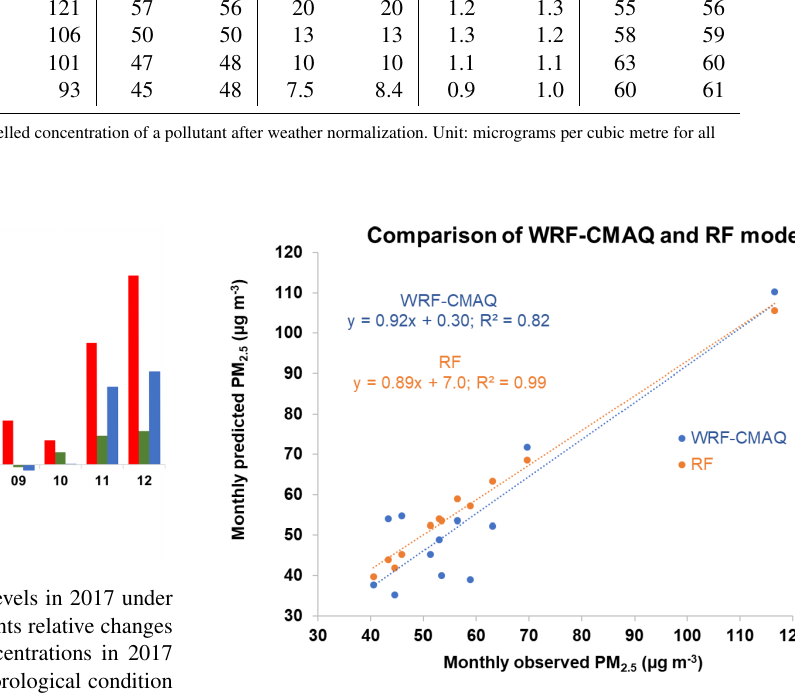
Table 1. A comparison of the annual average concentrations of air pollutants before and after weather normalization. Pollutants PM 2 . 5 PM 10 NO 2 SO 2 CO O 3 Year Obs. Model Obs. Model Obs. Model Obs. Model Obs. Model Obs. Model